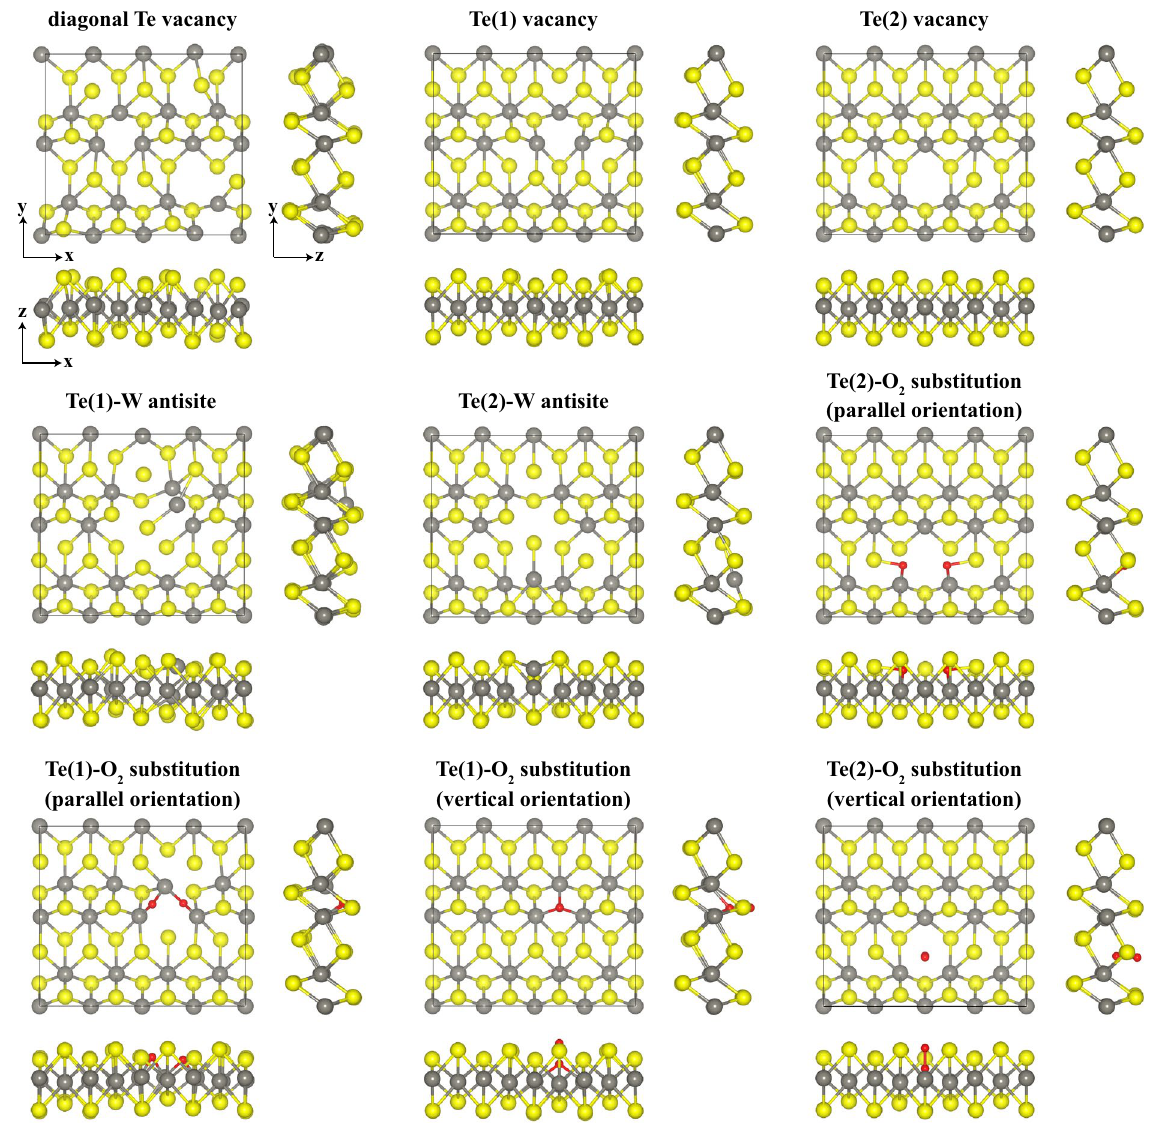
Figure 6. Ball and stick model of optimized atomic structures of defective 1L 1T ′ WTe 2 . W atoms are displayed in grey, Te atoms are displayed in yellow, and O atoms are displayed in